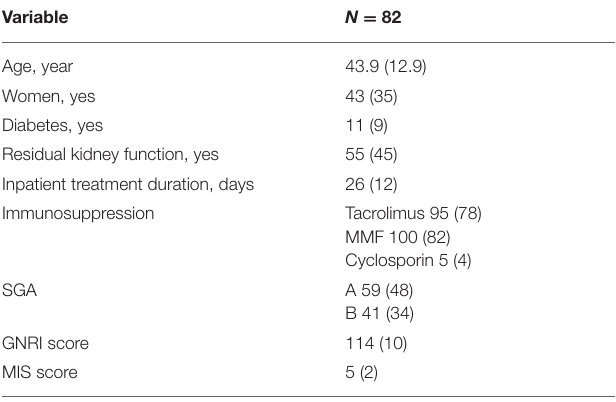
TABLE 1 | Baseline characteristics of kidney transplant recipients.